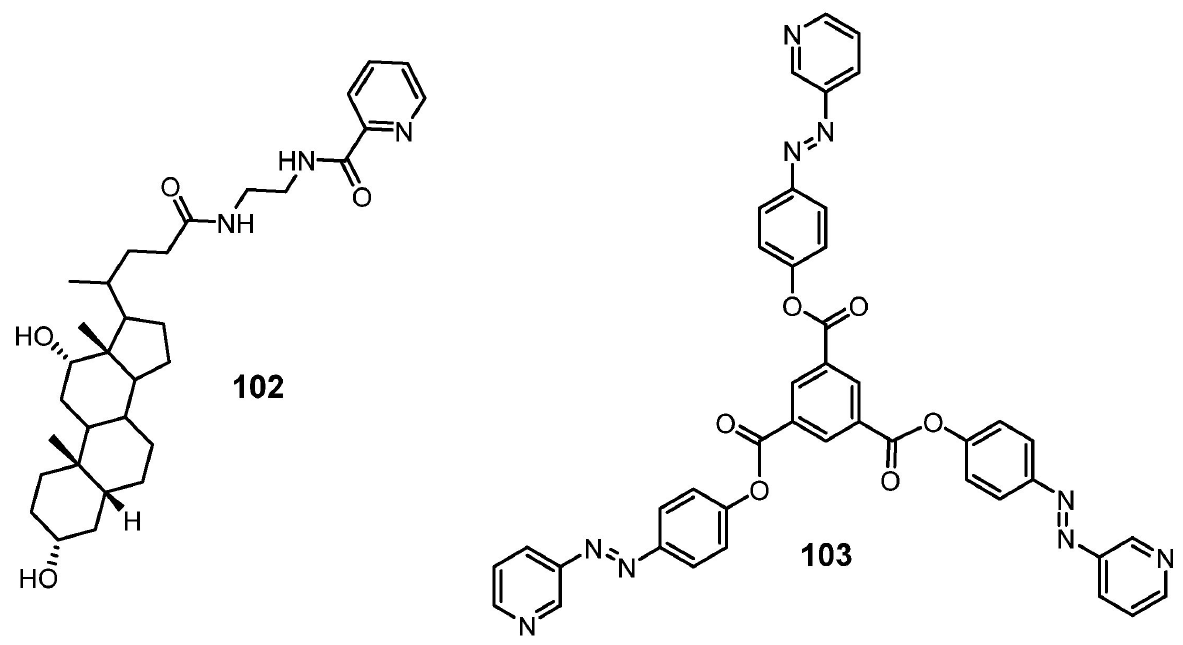
Figure 45. Molecular structure of ligands 102 and 103